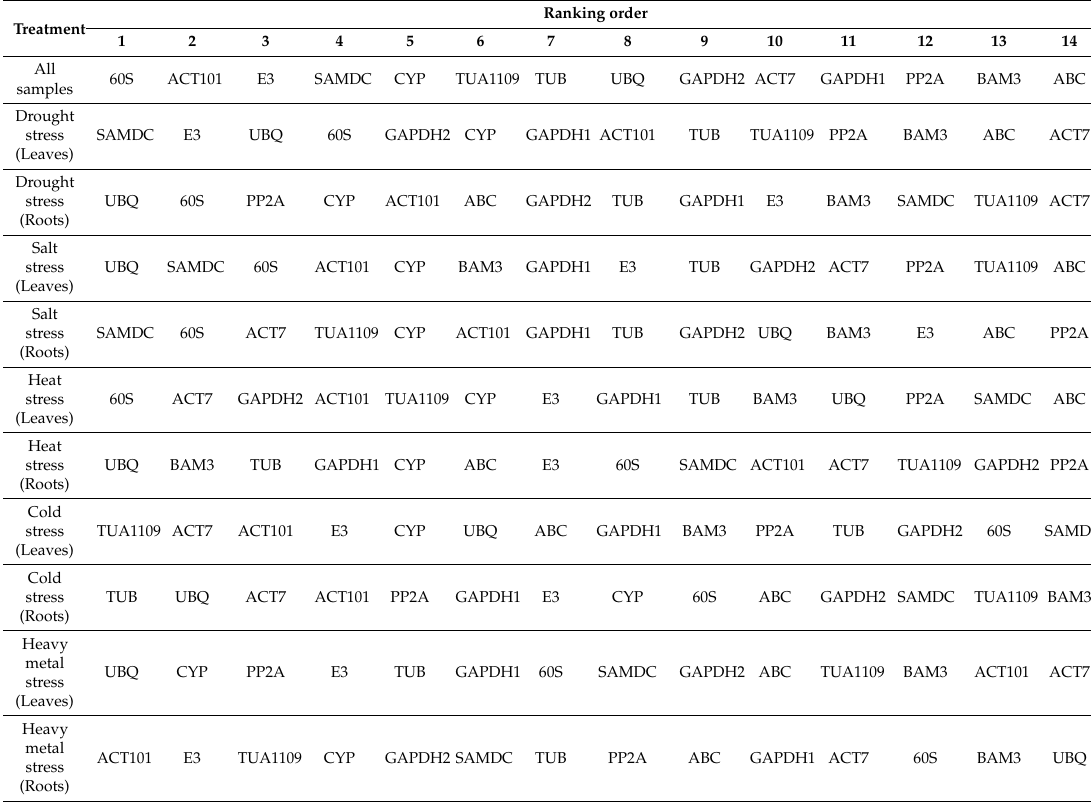
Table 4. Expression stability values for white clover candidate reference genes calculated using